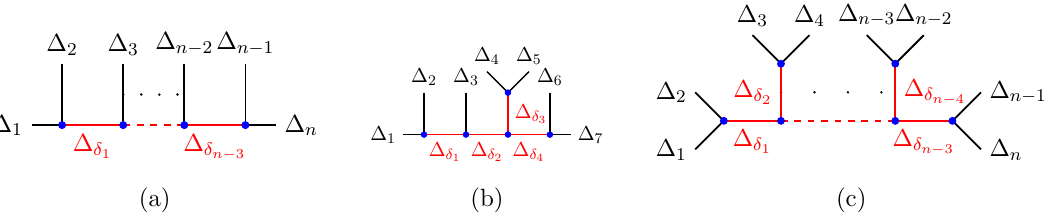
Figure 1. Graphical representation of conformal blocks: any n -point block admits a unique repre- sentation as an unrooted binary tree with n leaves, and consequently n − 3 internal edges (colored red to guide the eye) and n − 2 internal nodes/vertices (marked in blue). All edges are labeled with conformal dimensions; the labels on external edges (edges attached to the leaves of the un- rooted tree) are shown at the leaves for better